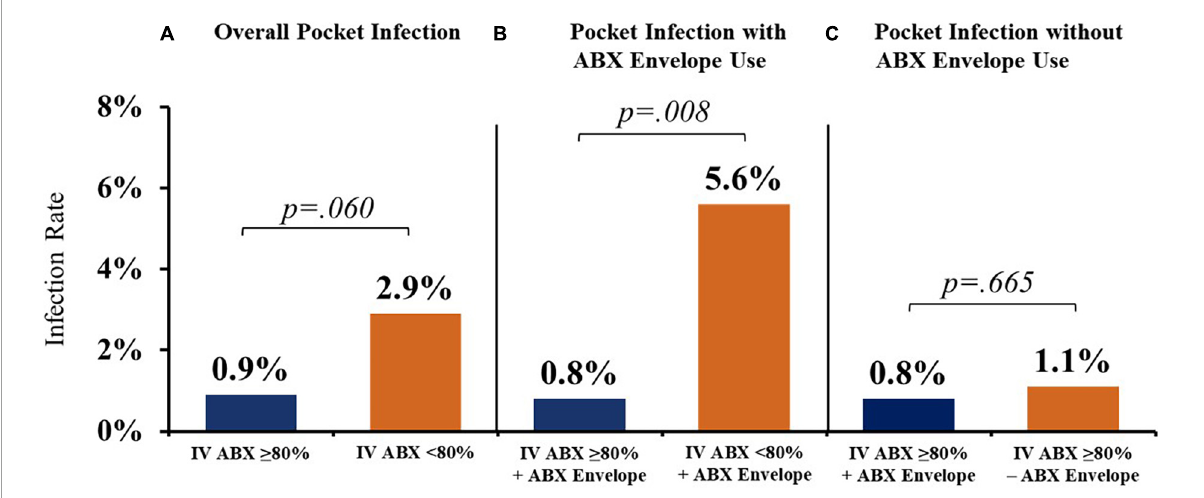
FIGURE3 Cardiac implantable electronic device (CIED) pocket infection rates with various prevention strategies. (A) Higher IV ABX compliance ( ≥ 80% use) was associated with a lower overall rate of CIED pocket infection vs. sites with < 80% IV ABX compliance. (B) When stratifying for antibacterial biologic envelope usage in conjunction with IV ABX ≥ 80% site compliance vs. < 80% compliance, there was a significant difference in pocket infection rates. (C) Use of an antibacterial (vs. saline-only) envelope was associated with a trend toward a lower infection rate for sites with